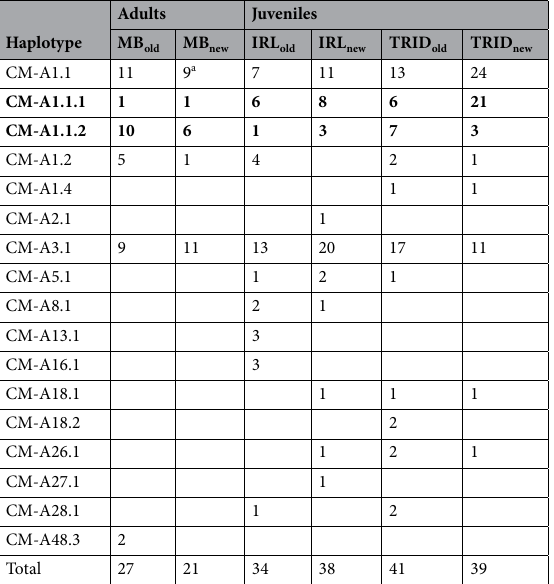
Table 2. Haplotypes identified using the 829 bp mitochondrial DNA fragment. MB old (nesting females before 2000), MB new (nesting females between 2016 and 2018); IRL old and TRID old (foraging sites between 2003 and 2005); IRL new and TRID new (foraging sites between 2016 and 2018). Bold rows indicate sequencing of a diagnostic fragment to distinguish between variants of haplotype CM-A1.1. IRL Indian River Lagoon, Trident Trident Submarine Basin. a 2 samples failed to amplify the diagnostic sequence for